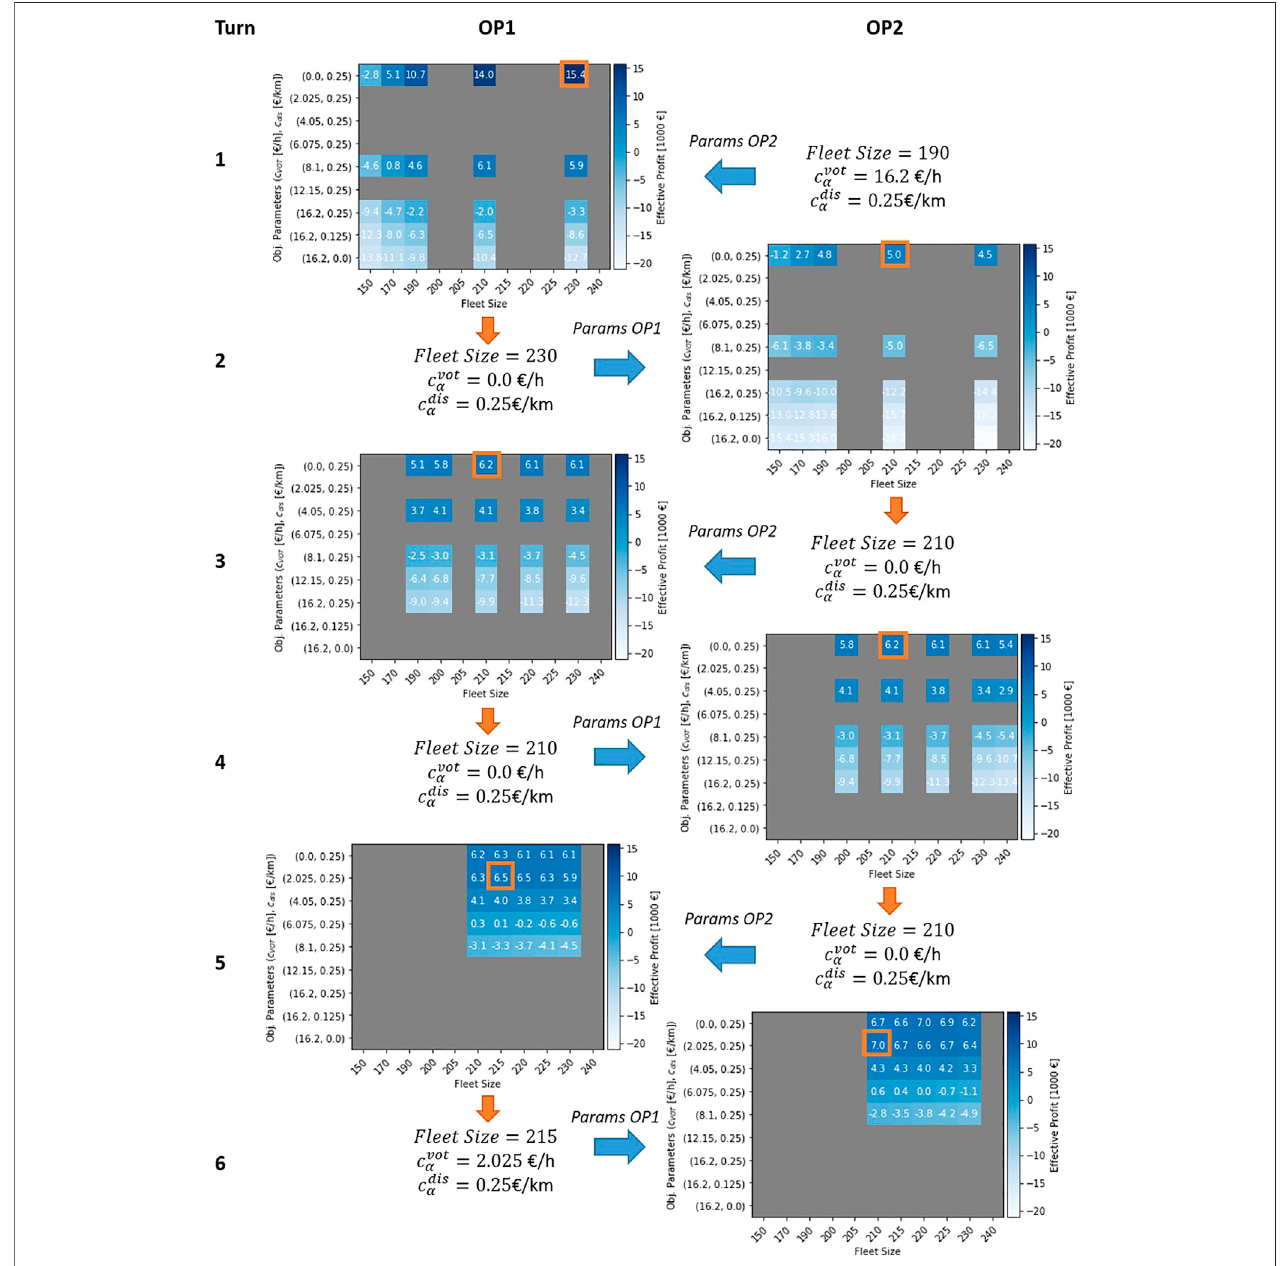
FIGURE 7 | Illustration ofthe development ofoperator parameters over the course of the game for the broker interaction scenario. Blue arrows indicate parameter settings of the passive operator. Orange arrows indicate the parameter selection resulting in the highest effective pro fi t of the active operator. A fi rst equilibrium can be observedatturn4,whenOP2adjustsitsparameterstothesameparametersasOP1.Afterturn6alternatingbehaviorisrevealedoncethestepsizeisdecreasedfurther in turn 5.